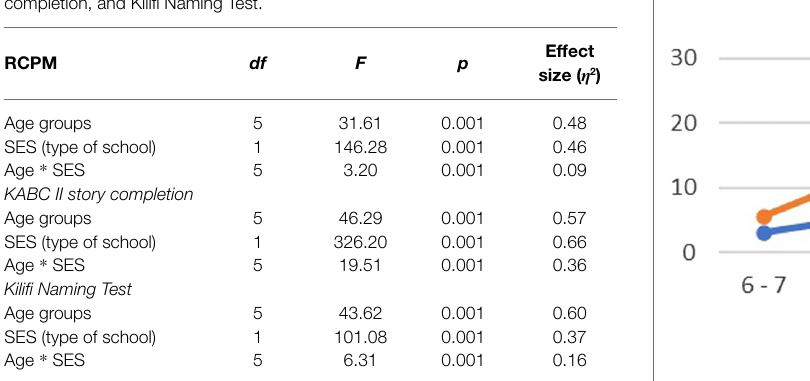
TABLE 4 | Effects of age and SES (type of school) on RCPM a , KABC b II story completion, and Kilifi Naming Test.